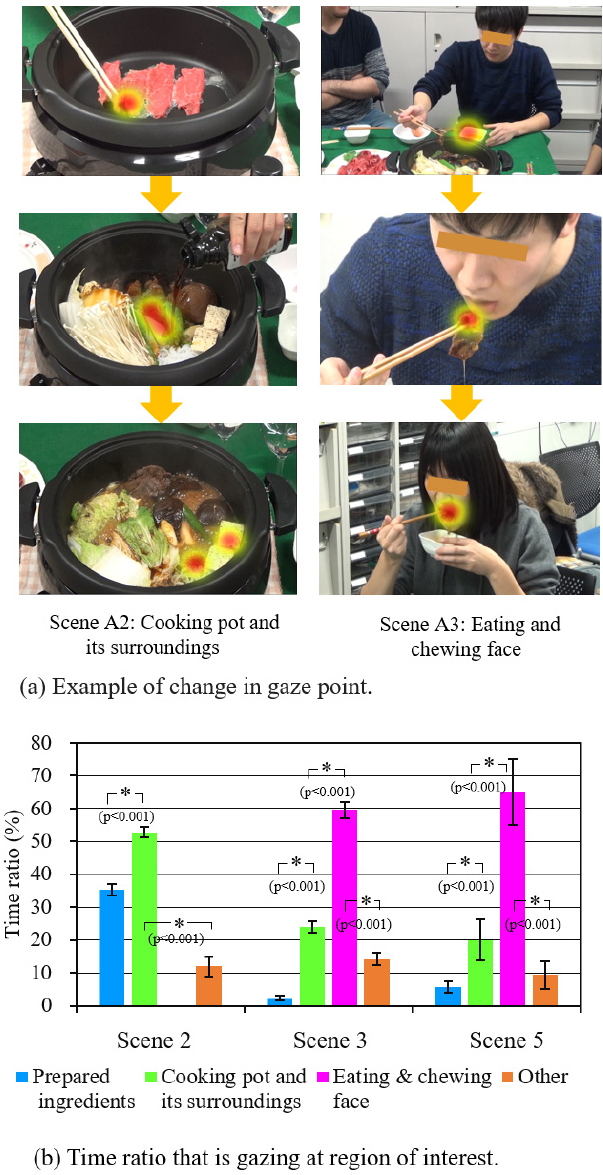
Figure 7. Gaze-point measurement results.